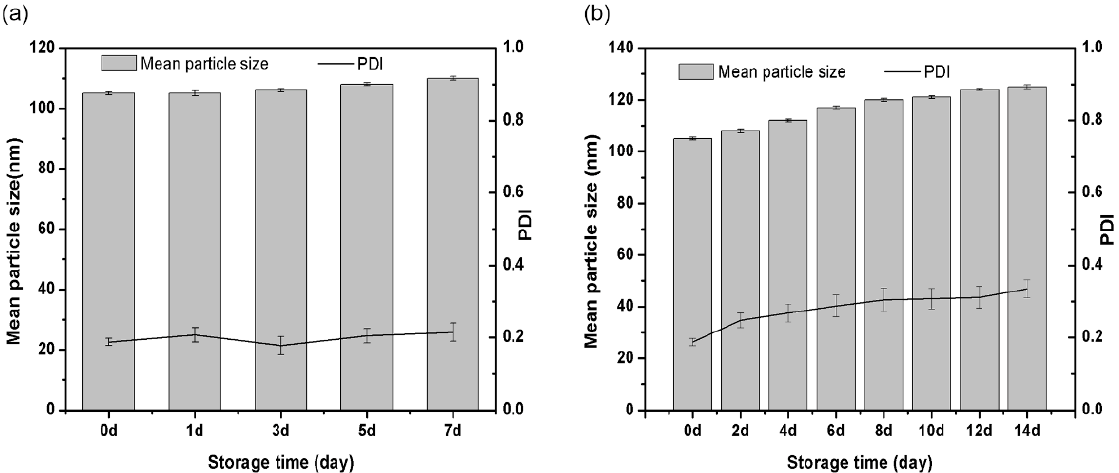
Figure 4. The mean particle size and PDI of the BNPs at different storage temperature. ( a ) BNPs at 0 °C for 7 days, ( b ) BNPs at 54 °C for 14 days.